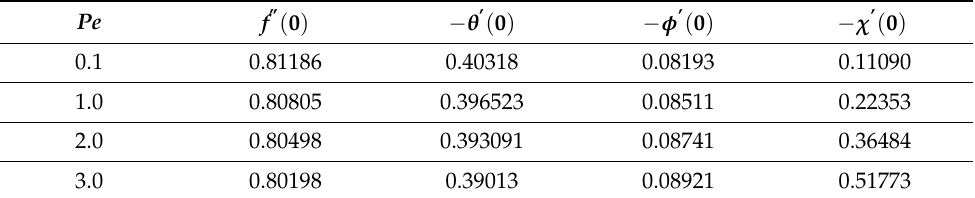
Physical behavior of ( a ) f (cid:48)(cid:48) ( 0 )( b ) − θ (cid:48) ( 0 )( c ) − φ (cid:48) ( 0 )( d ) − χ (cid:48) ( 0 ) at angle π /6 when Nr = 0.2, Rb = 0.1 K P = 0.5, M = 0.1 W e = 0.2, Pr = 3.0, Nt = 0.1, Nb = 2, Sc = 0.2, Scn = 0.2, λ =